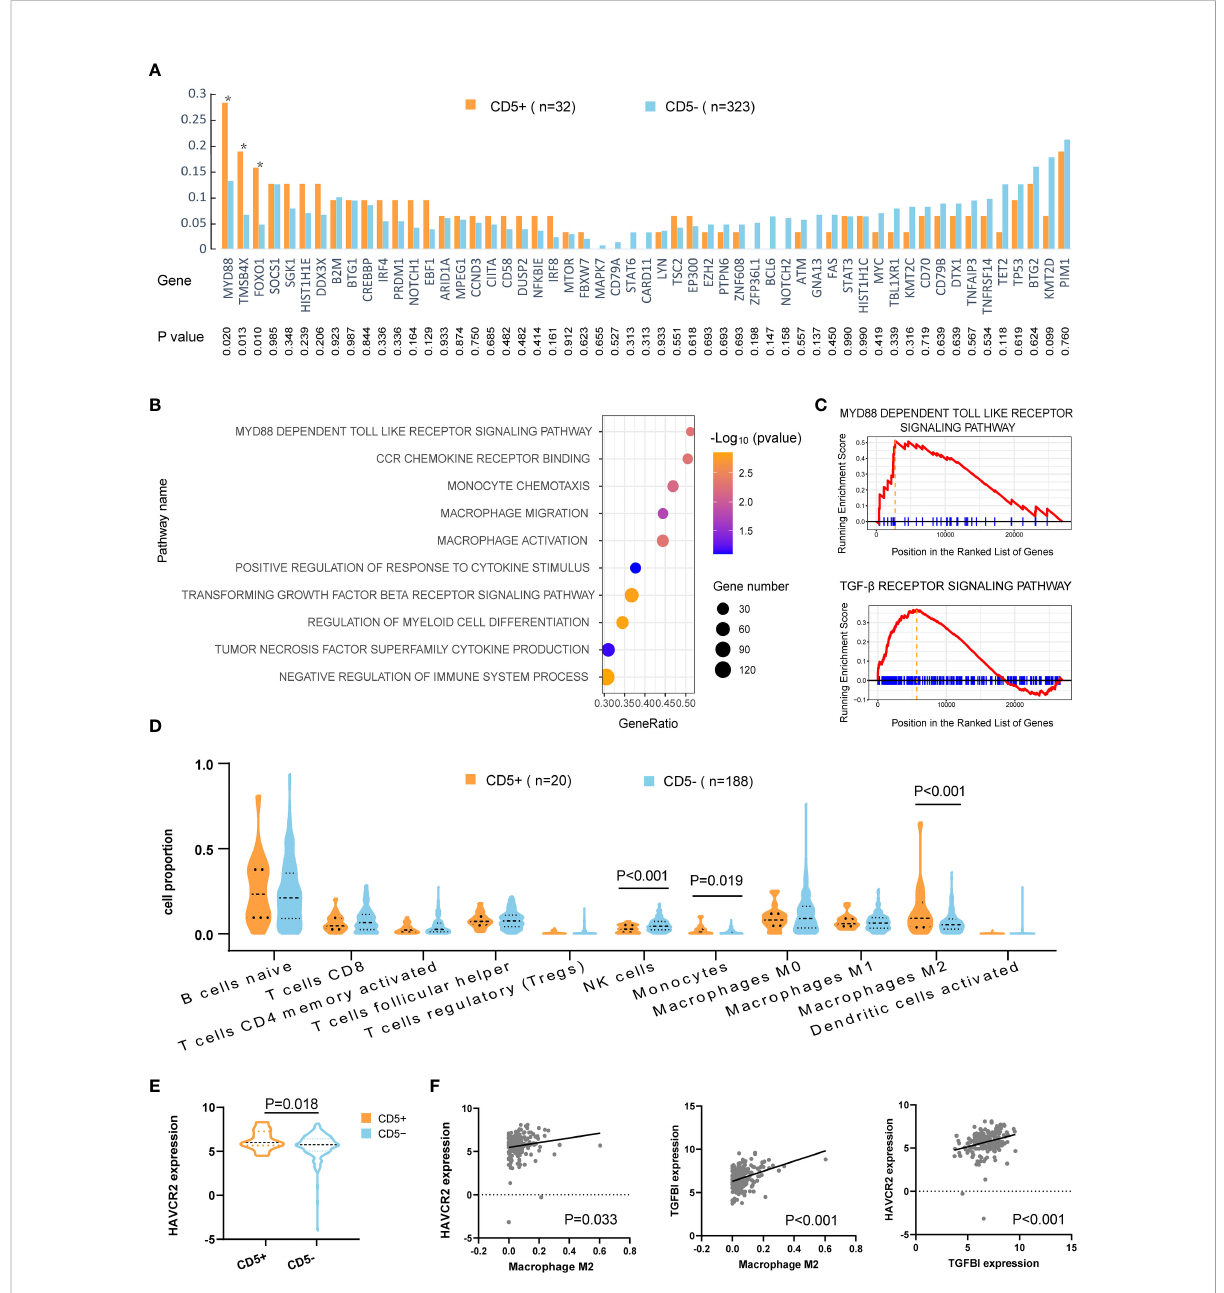
FIGURE 3 Mutation patterns and tumor microenvironment of CD5+ non-DE patients. (A) Genetic mutations of 55 genes in CD5+ (n = 32) and CD5 − (n = 323) non-DE patients. P values are listed in the lower part of the graph. (B) Upregulated gene ontology (GO) pathways in CD5+ non-DE (n = 20) compared with CD5 − non-DE (n = 188) patients. The color gradient represents − log 10 (p value) of GO pathways, the point size indicates the gene numbers involved in each gene set, and the position of the x -axis indicates the gene ratio of genes enriched in each gene set. (C) Enrichment plot of MYD88-dependent Toll-like receptor signaling pathway and TGF- b receptor signaling pathway. (D) Proportion of immune cells in the tumor microenvironment of CD5+ non-DE (n = 20) and CD5 − non-DE (n = 188) patients. (E) Normalized expression of HAVCR2 (TIM3) comparing CD5+ non-DE (n = 20) and CD5 − non-DE (n = 188) patients. (F) Correlation between M2 macrophage proportion and normalized expression of HAVCR2 or TGFBI, and correlation between normalized expression of HAVCR2 and TGFBI. P values were listed in each